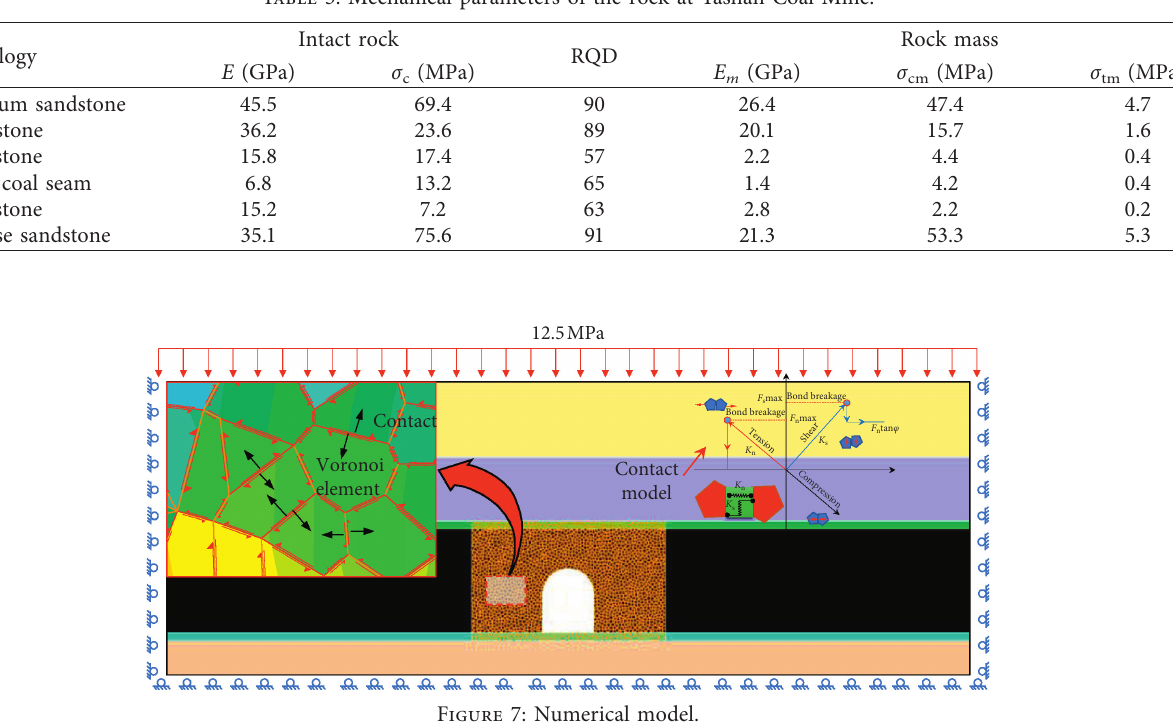
Table 5: Mechanical parameters of the rock at Tashan Coal Mine.